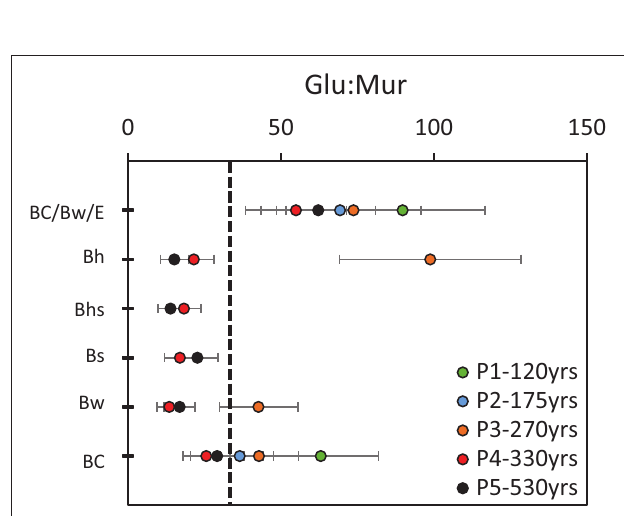
FIGURE 5 | Evolution of the ratio between glucosamine and muramic acid content (two amino-sugars) in the horizons of the 5 profiles of increasing age (error bars represent ± one standard